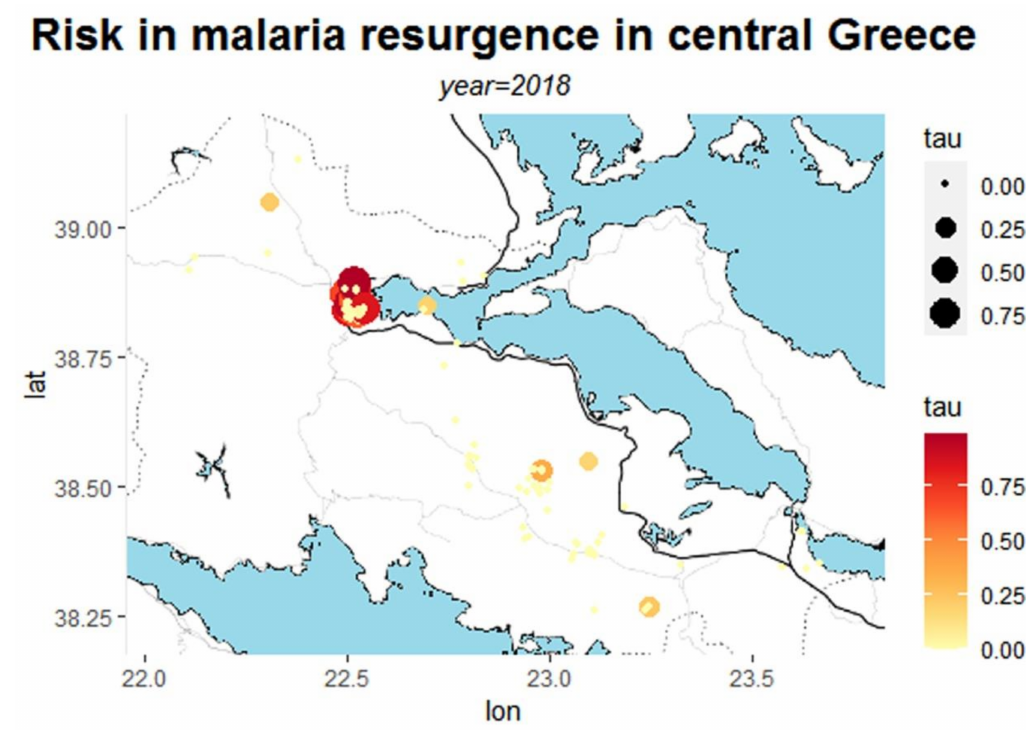
Figure A2. Point estimate map of risk of malaria transmission ( τ estimates).